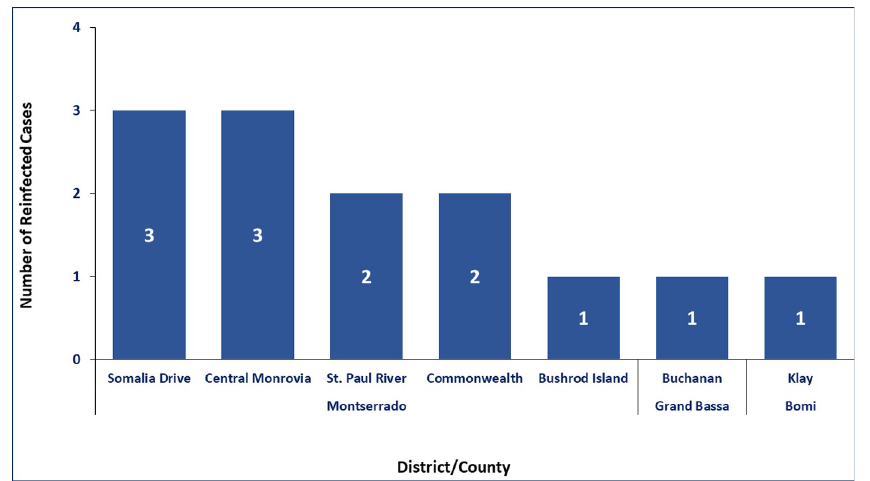
Fig 3. Distribution of reinfection by district/county in Liberia, March 15, 2020 to July 31, 2021.